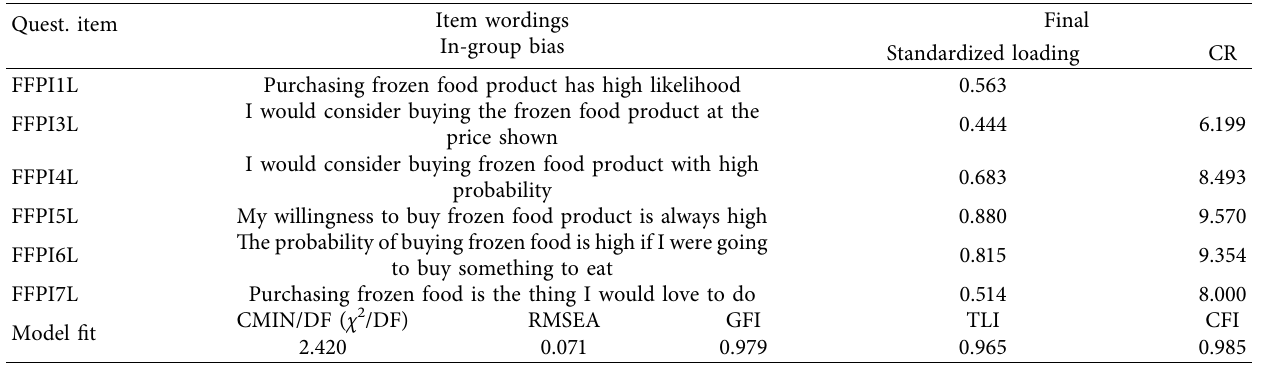
Table 7: Model fit summary (confirmatory factor analysis of fast food purchase intentions).